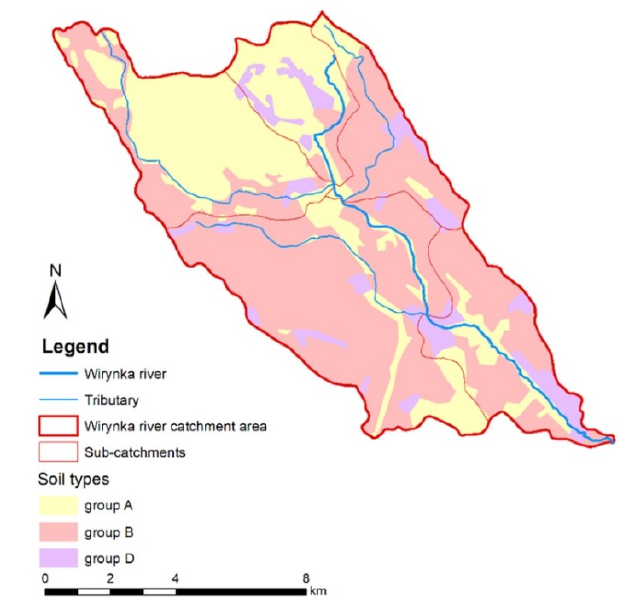
Figure 6. Soil types for the Wirynka river catchment area.